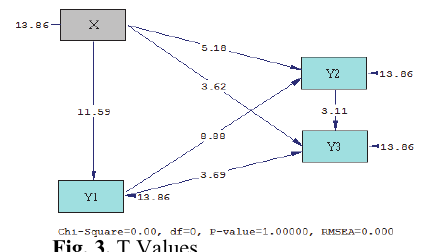
Path Coef- T-Value/ ficients